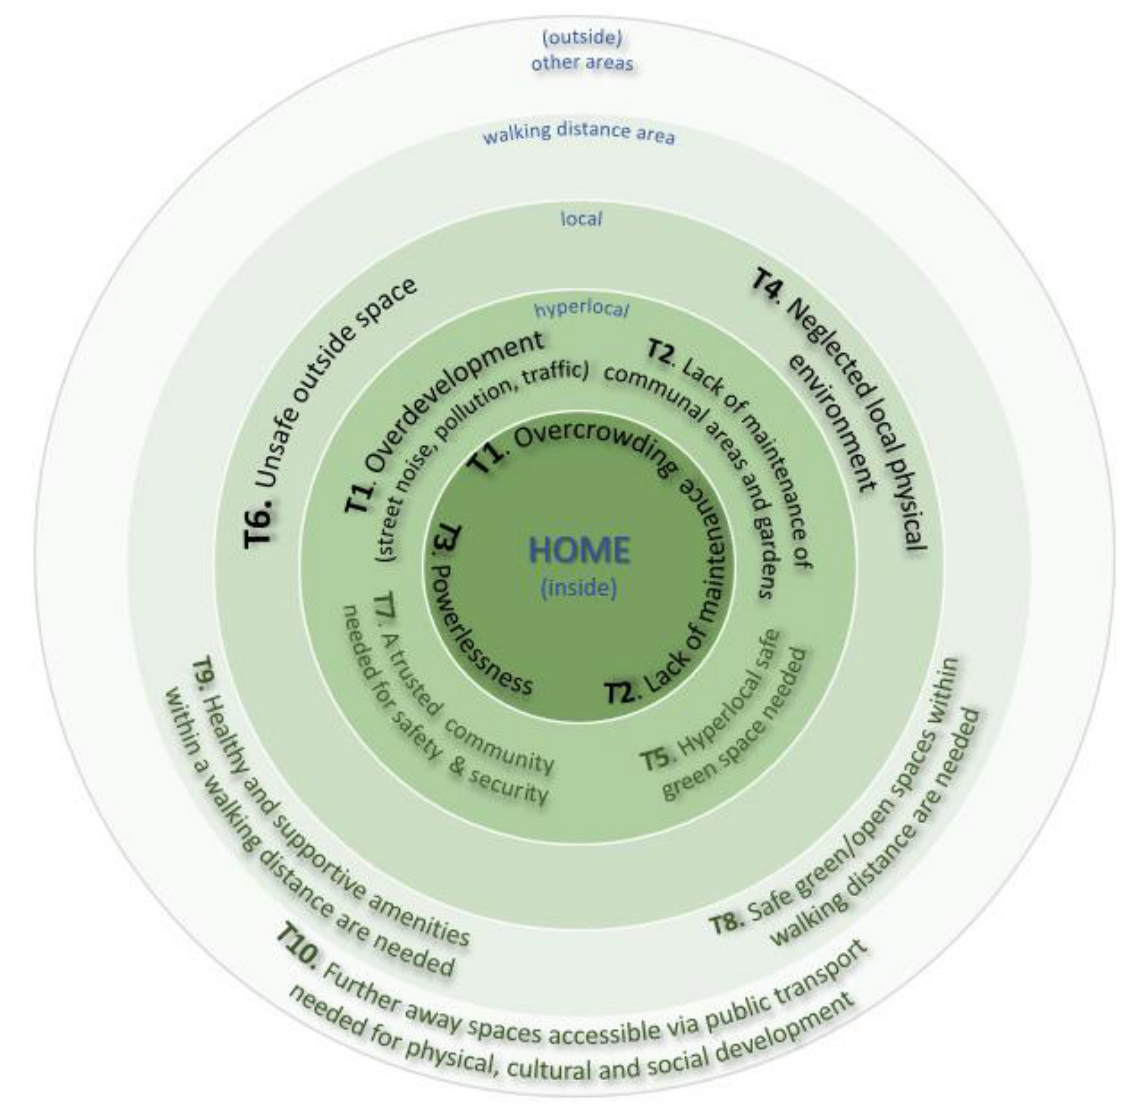
Figure 5. Spatial dimension of emerging themes.